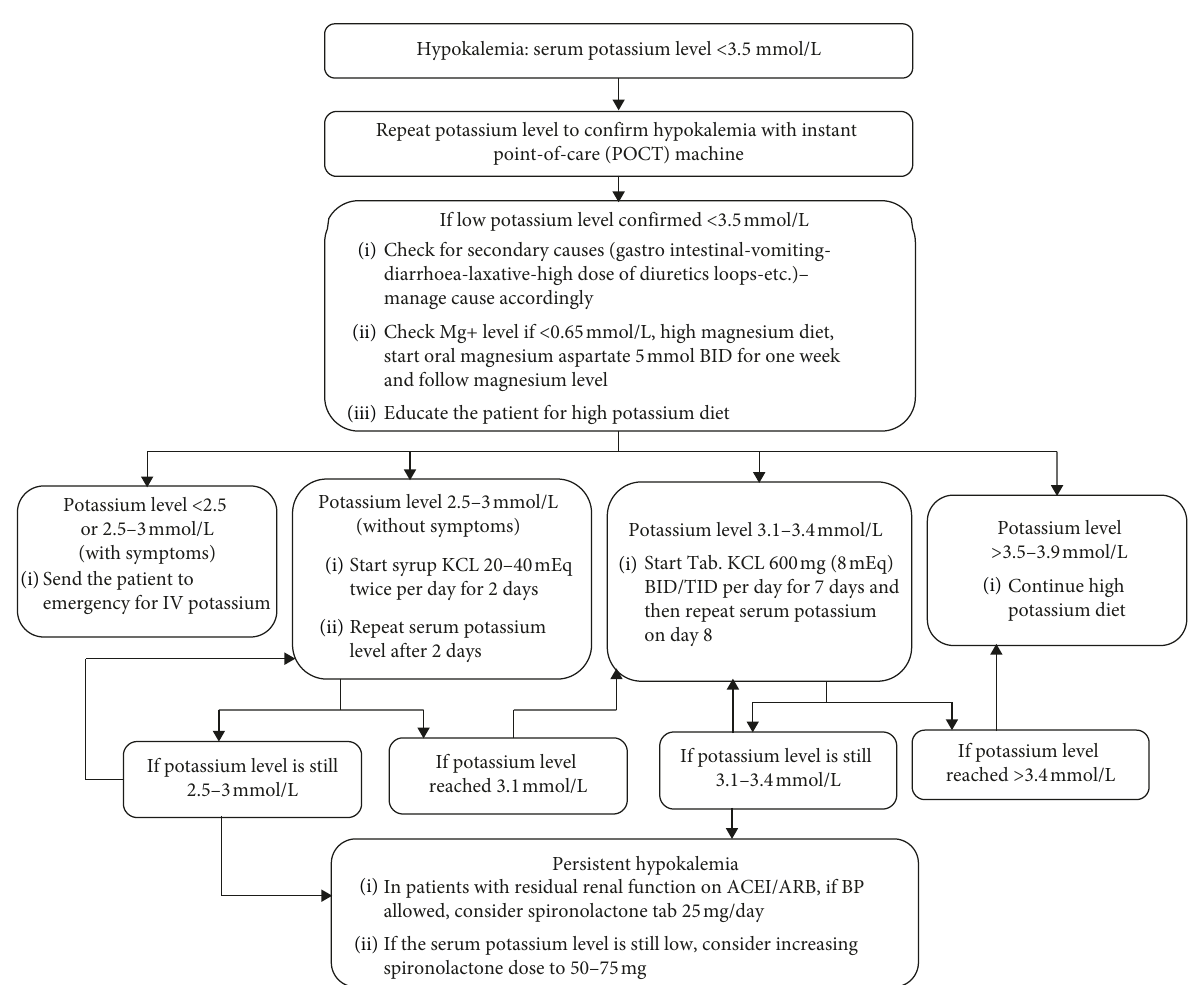
Figure 1: Updated hypokalemia management pathway in peritoneal dialysis